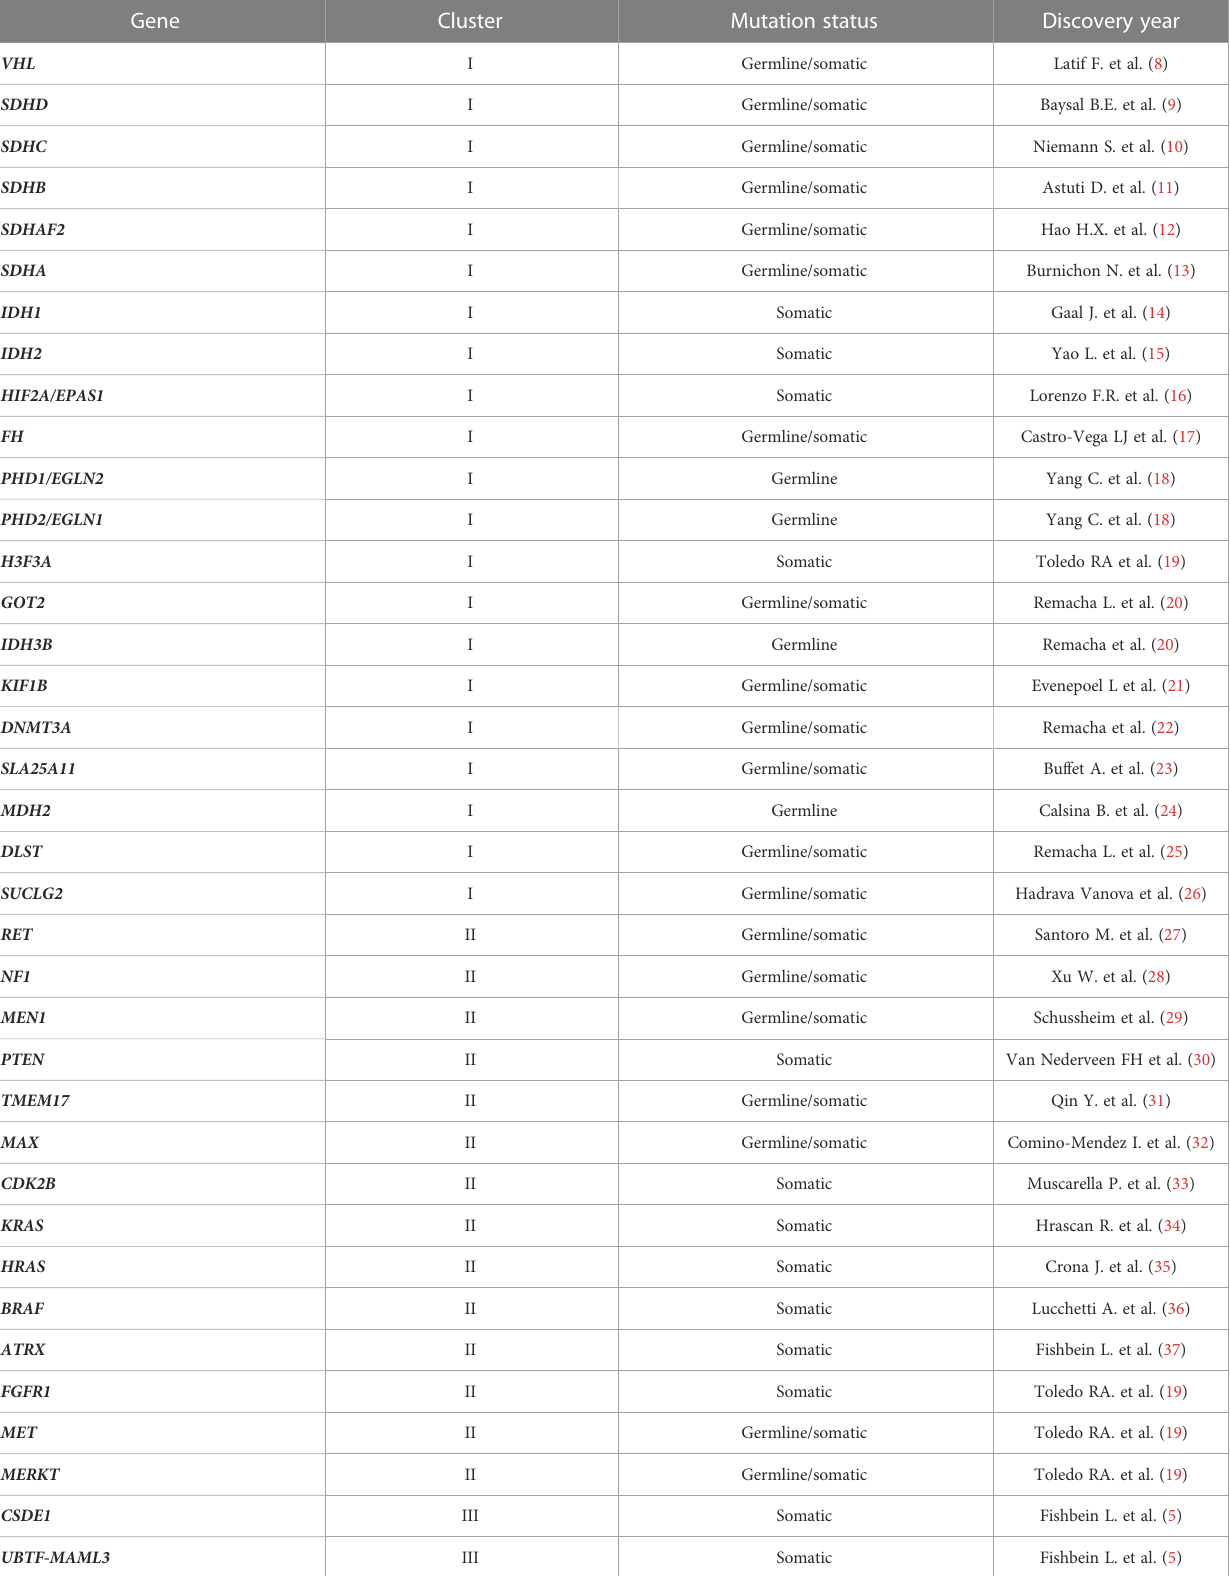
TABLE 1 Pheo/PGL susceptibility